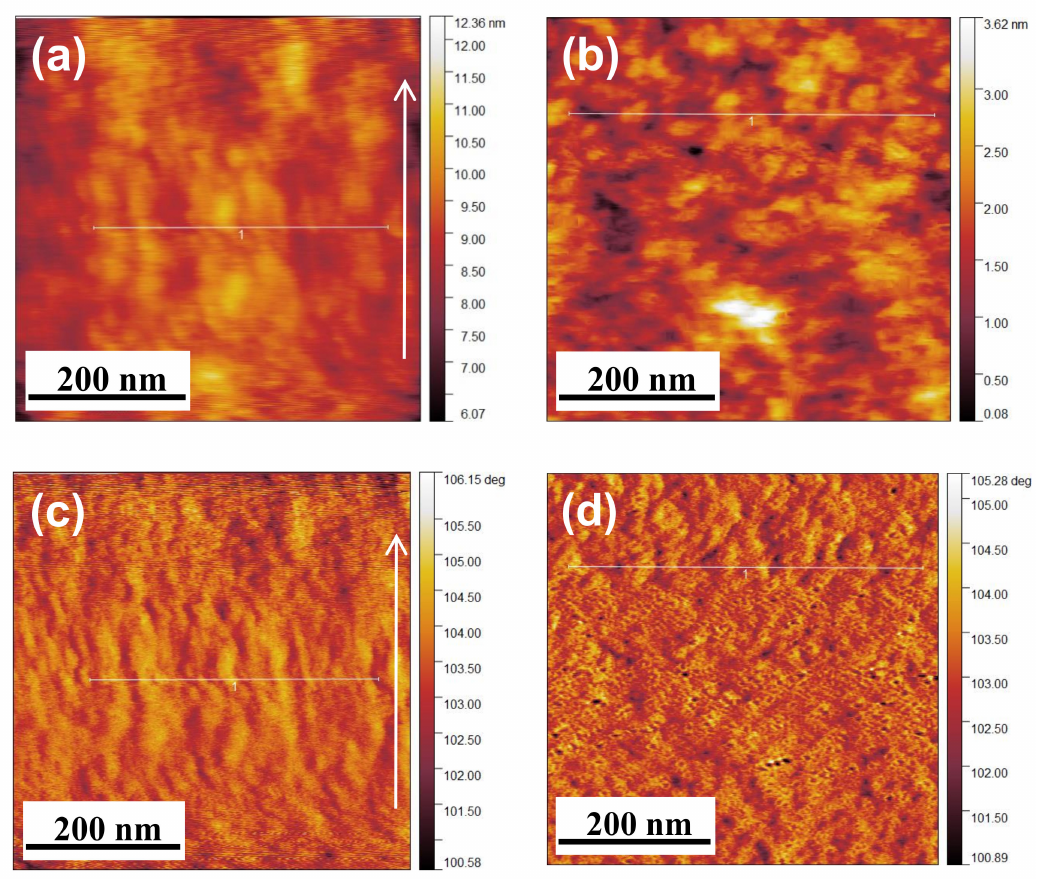
Figure 8. AFM data of Nafion/PEO(99:1) composites. Topology images of the ( a ) NF and ( b ) film. Phase images of the ( c ) NF and ( d ) film. The white arrows show the fiber axis direction. All observations were carried out at 25 ◦ C and 40% RH. The line profiles of all the images are shown in Figure